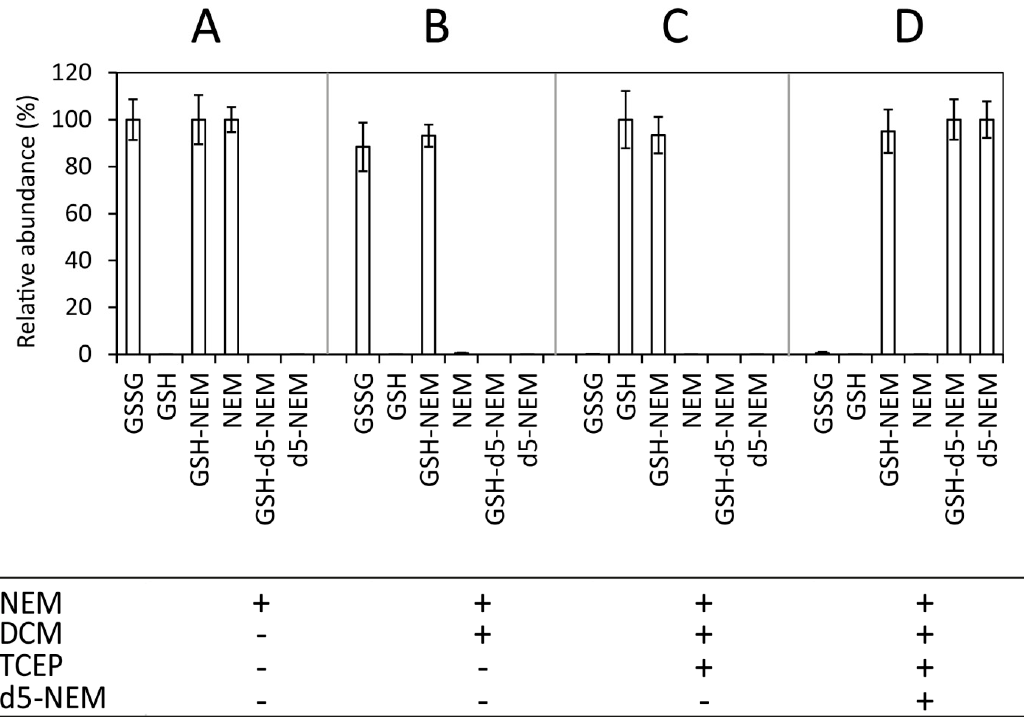
Figure 2. Step-by-step analysis of completeness and selectivity of derivatization of reduced-to-oxidized-glutathione ratio determination workflow. Four technical replicates of 100 µ mol / L of GSH and 10 µ mol / L of GSSG standard were mixed and processed as indicated by plus icons in the table below the panel (steps A–D ). Nonderivatized samples resulted in a massive standard deviation (S.D.) for both GSH and GSSG due to oxidation; thus, they are not shown in this figure. Bars represent means of MRM signal areas normalized on the mean of MRM signal area of the corresponding analyte ± S.D. at its first appearance in the panel: all GSH–NEM, GSSG, and NEM signals were normalized on signals of GSH–NEM, GSSG, and NEM, respectively, measured after the first step of the procedure (NEM addition, panel A). Due to high variation of GSH without the addition of NEM, GSH was normalized on the GSH signal measured after GSSG reduction (panel C). GSH-d 5 -NEM and d 5 -NEM signals were normalized on the signals of GSH-d 5 -NEM and d 5 -NEM after reduction / second alkylation step (panel